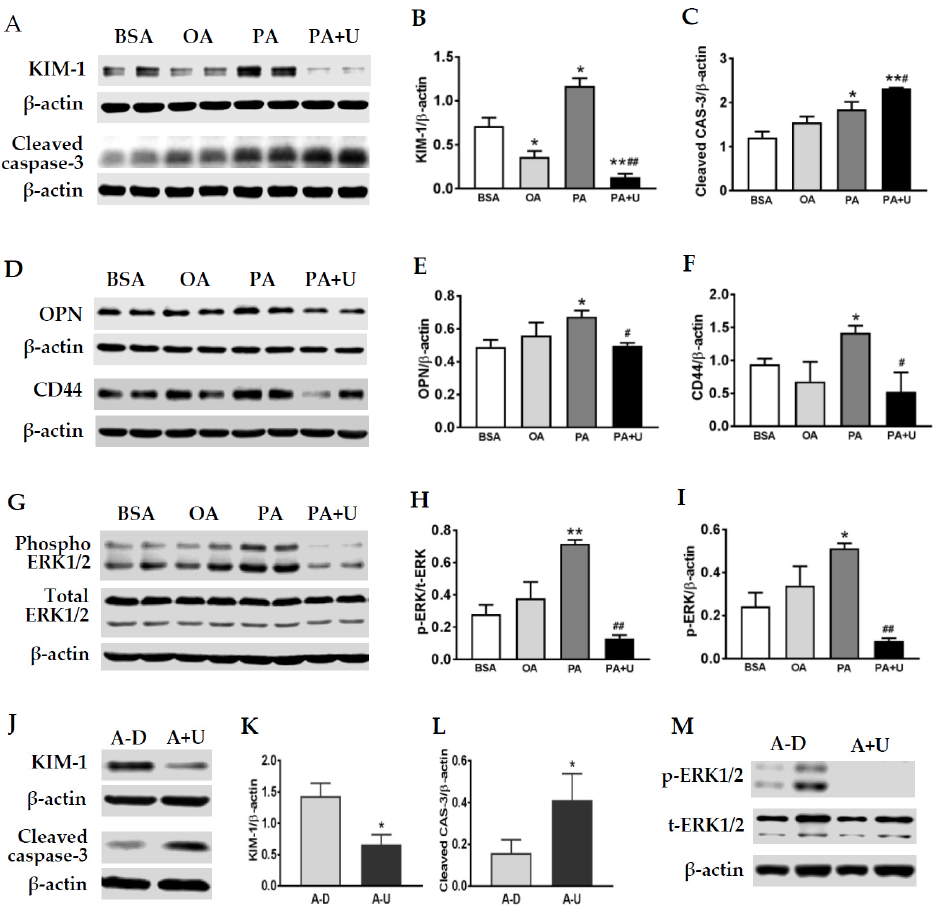
Figure 5. Increased KIM-1, cleaved caspase-3, OPN, and CD44 proteins in palmitate-treated TECs. Compared to the albumin (BSA) control, representative Western blot images and quantitative bar graphs show that KIM-1 ( A , B ), cleaved caspase (CAS)-3 ( A , C ), OPN ( D – E ), and CD44 ( D , F ) proteins were significantly increased in primary rat tubular epithelial cells (TECs) treated with palmitate (PA) but not oleate (OA). The phospho-ERK (p-ERK)1 / 2 level was significantly higher in TECs treated with PA for 24 h ( G – I ). Pretreatment of TECs with U0126 (U) inhibited ERK1 / 2 phosphorylation and abolished palmitate-induced KIM-1, OPN, and CD44 upregulation. In albumin control cells, U0126 (A-U) also reduced KIM-1 ( J , K ) and increased cleaved CAS-3 ( J , L ) compared to the DMSO vehicle group ( A – D ), which was associated with an inhibition of ERK1 / 2 activation ( M ). Values are the mean ± SEM. n = 3–4 individual experiments / group. * p < 0.05, ** p < 0.01 vs. the BSA control; # p < 0.05, ## p < 0.01 vs. PA